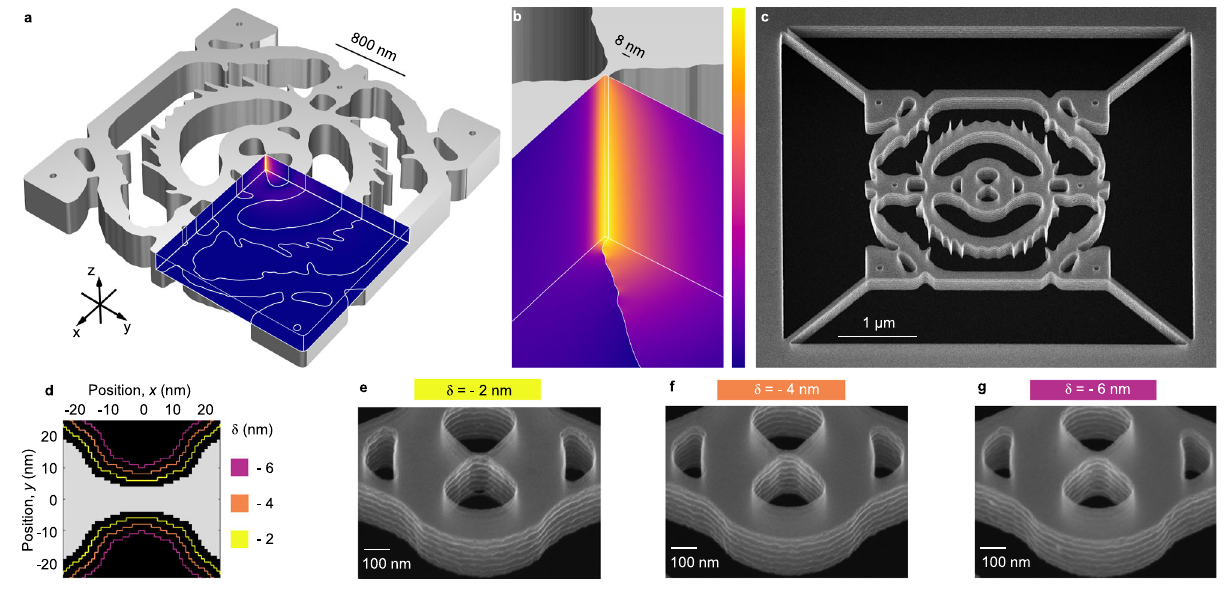
Fig. 1 | Fabrication of topology-optimized silicon dielectric bowtie cavity (DBC). a Rendering of the DBC design generated by tolerance-constrained topol- ogy optimization. The normalized ∣ E ∣ - fi eld is projected on the faces de fi ning the three symmetry planes of the design. b Zoom-in of the solid silicon bowtie exhi- bitingastrong fi eldcon fi nementduetothebowtiebridgedimensionof8nm. c 40° tilted scanning electron microscopy (SEM) image of a fabricated cavity. d Global geometry-tuning, δ . Each air (black) pixel (1nm 2 ) inside a δ -outline is exposed